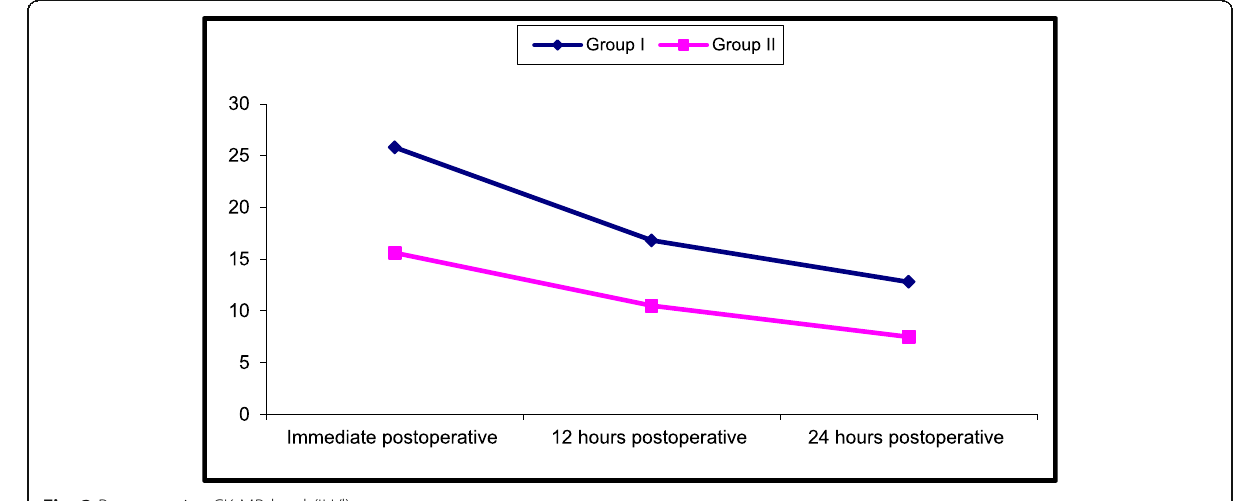
Fig. 3 Postoperative CK-MB level